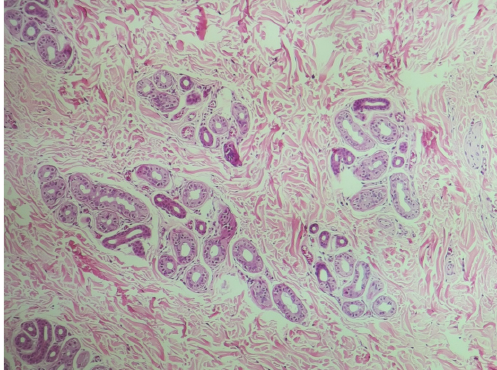
Figure 2: Polypoid lesion protruded to umbilicus covered by acanthotic epidermis.